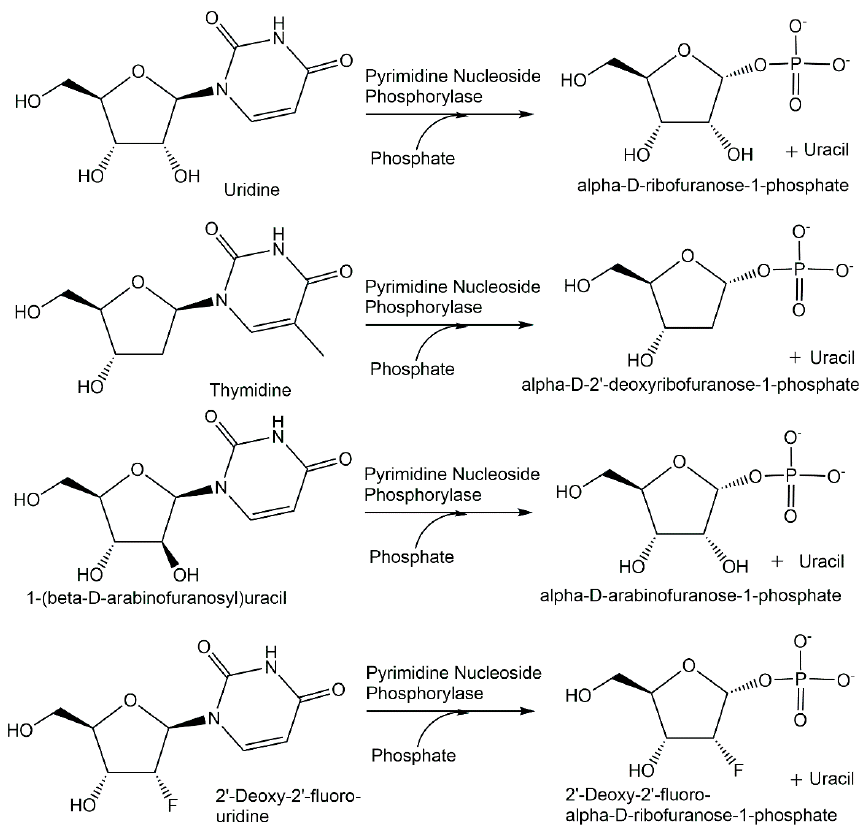
Figure 15. Synthetic applications of phosphorylases in phosphorylation reactions.